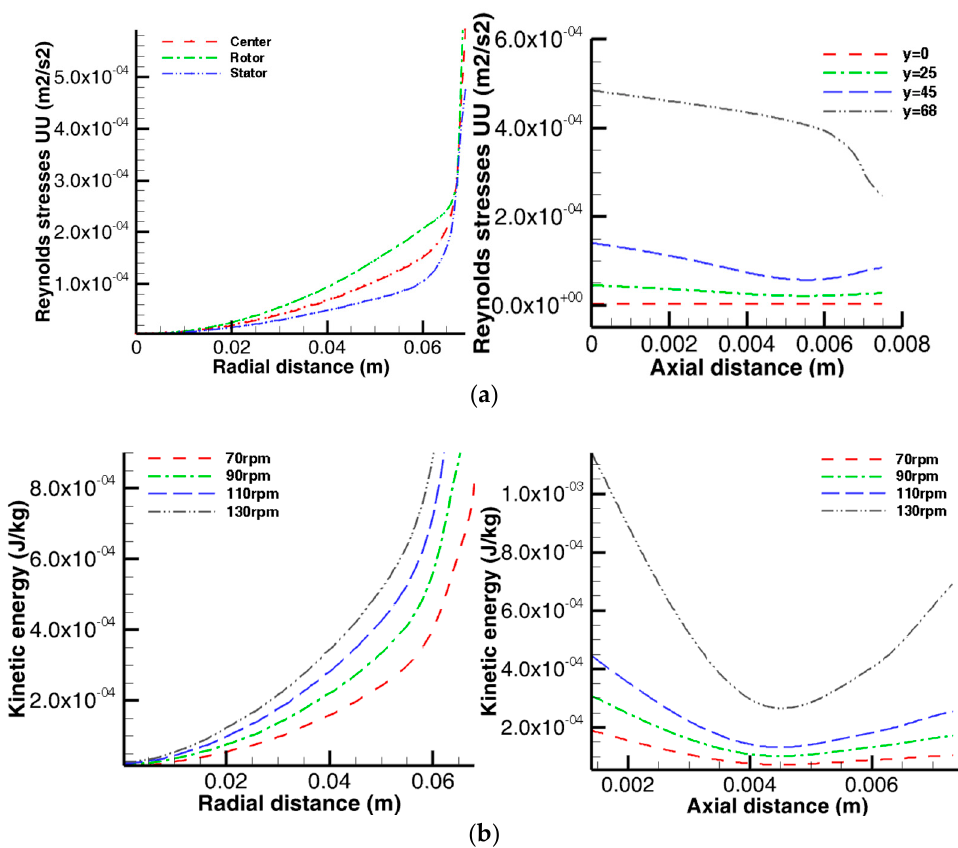
Figure 9. Spatial distribution of the turbulence and mixing intensities ( a ) Reynolds stress distributions on the Y-Z plane at x = 0.0015, 0.003725, and 0.006, and X-Z plane parallel to the shaft at y = 0, 0.025, 0.045, and 0.068. ( b ) Turbulent kinetic energy distribution on the Y-Z plane at x = 0.003725 and X-Z plane parallel to the shaft at y = 0.025 for N = 70–130 rpm.